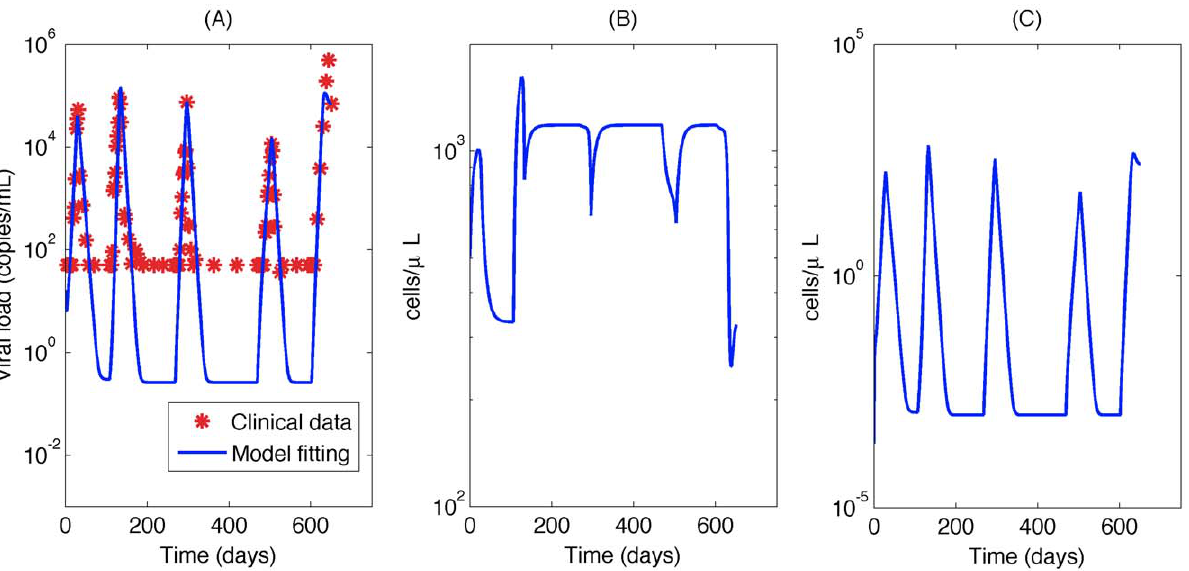
Figure 6. Typical Bayesian Posterior Mean Results. (A)The fitted viral load curve and viral load data for patient 1; (B)Target cell simulation using fitted parameters; (C)Infected cell simulation using fitted parameters.